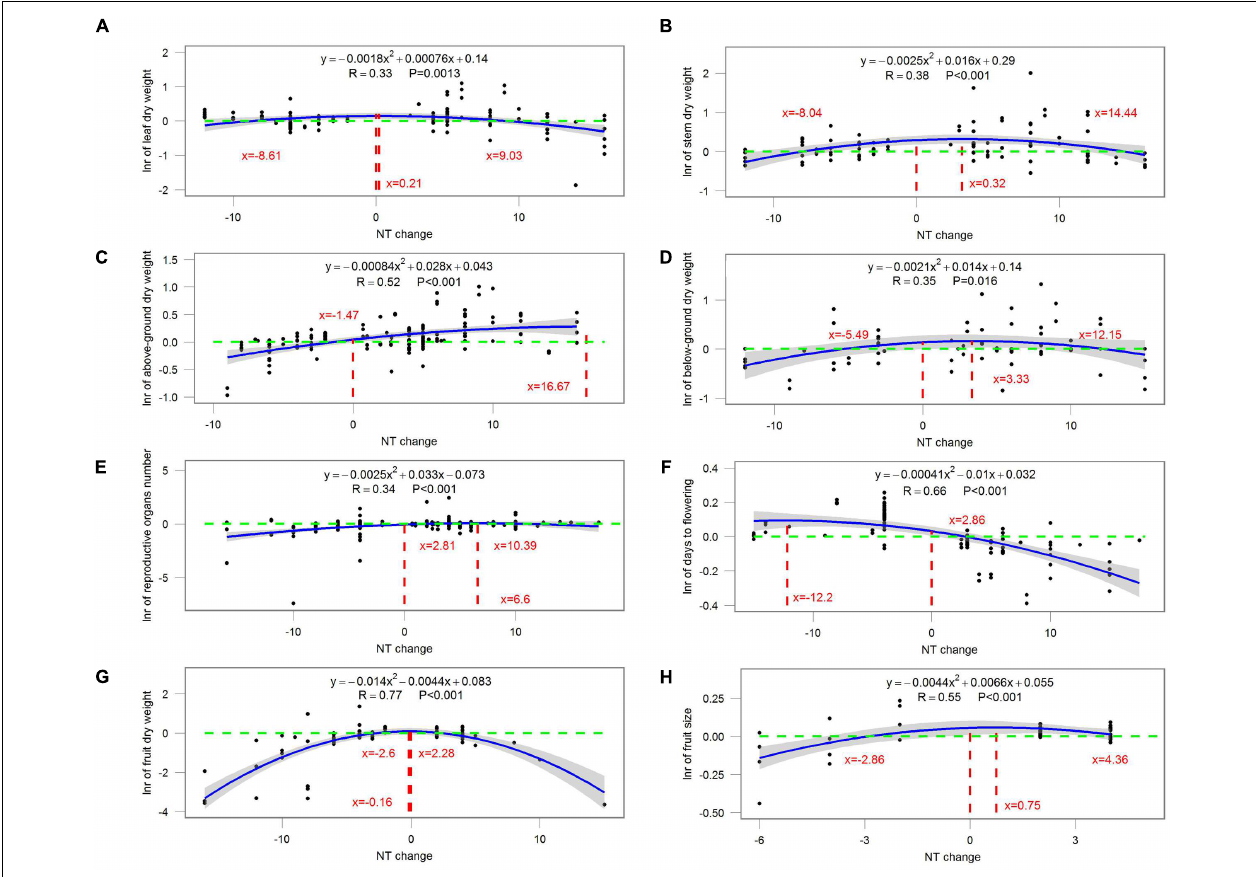
FIGURE 9 | Correlations between the magnitude of NT treatment and the response ratio of (A) leaf dry weight; (B) stem dry weight; (C) above-ground dry weight; (D) below-ground dry weight; (E) number of reproductive organs; (F) days to flowering; (G) fruit dry weight and (H) fruit size. Each point represents response ratio (lnr) to HNT or LNT. Regression function, variation coefficient and p -value are presented in the middle of each graph. Different lines indicate X = 0 (red line), x -value when y is the maximum, crossing points of y = 0 (green line) and regression